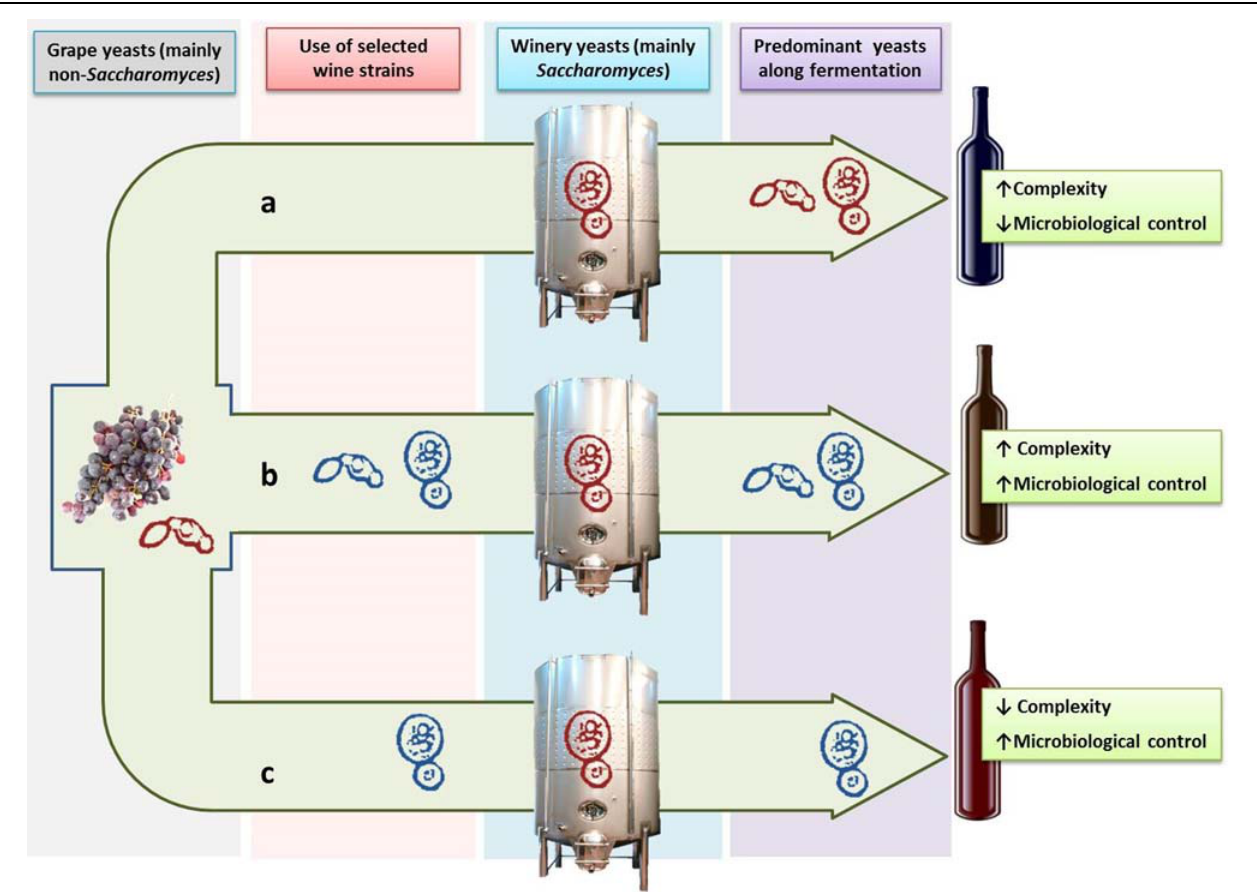
FIGURE 1 | Use of selected strains of Saccharomyces and non- Saccharomyces yeasts in winemaking. Spontaneous fermentation (a) allows the development of indigenous yeasts from grapes (mainly non- Saccharomyces ) and winery (mainly Saccharomyces ) leading to wines with a greater aromatic complexity but with less microbiological control. Inoculation with a selected strain of Saccharomyces cerevisiae (c) leads to a greater microbiological control but can reduce the aromatic complexity of wine. The use of mixed cultures of S. cerevisiae and non- Saccharomyces selected strains (b) allows to obtain wines with both greater aromatic complexity and microbiological control of the process. Autochthonous and inoculated selected yeasts are represented in red and blue color,